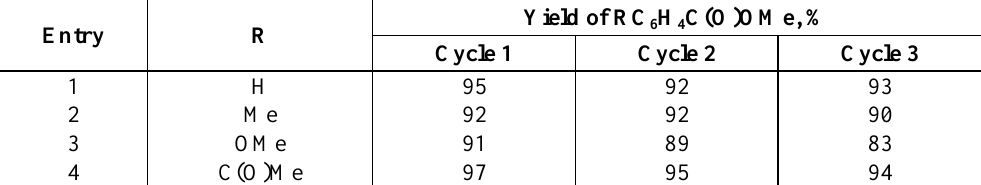
Table 4. Recycling the catalyst in the methoxycarbonylation